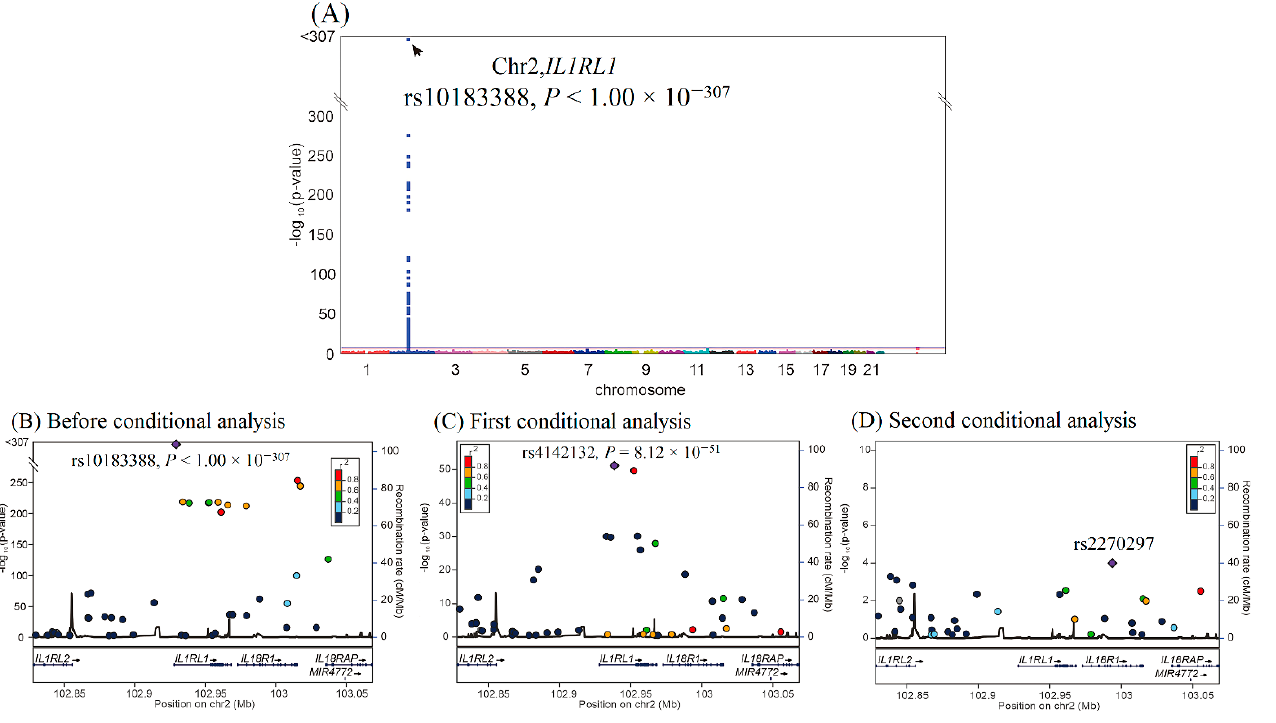
Figure 2. Conditional analysis of IL1RL1 candidate SNPs using GWAS data in the TWB cohort. ( A ) Manhattan plots for sST2 levels from the genome-wide association study of 4652 Taiwan Biobank participants depict the only one peak above genome-wide significance on chromosome 2q12.1, where the IL1RL1 gene is located (arrow). ( B ) Before conditional analysis, regional association plots for sST2 levels around the IL1RL1 locus show rs10183388 as the lead SNP. ( C ) After the first conditional analysis adjusting for rs10183388 genotype, rs4142131 in the regional plot at the IL1RL1 locus becomes a significant association with sST2 levels. ( D ) After the second conditional analysis adjusting for both rs10183388 and rs4142131, no more single SNP is found to be associated with sST2 levels signifi- cantly.